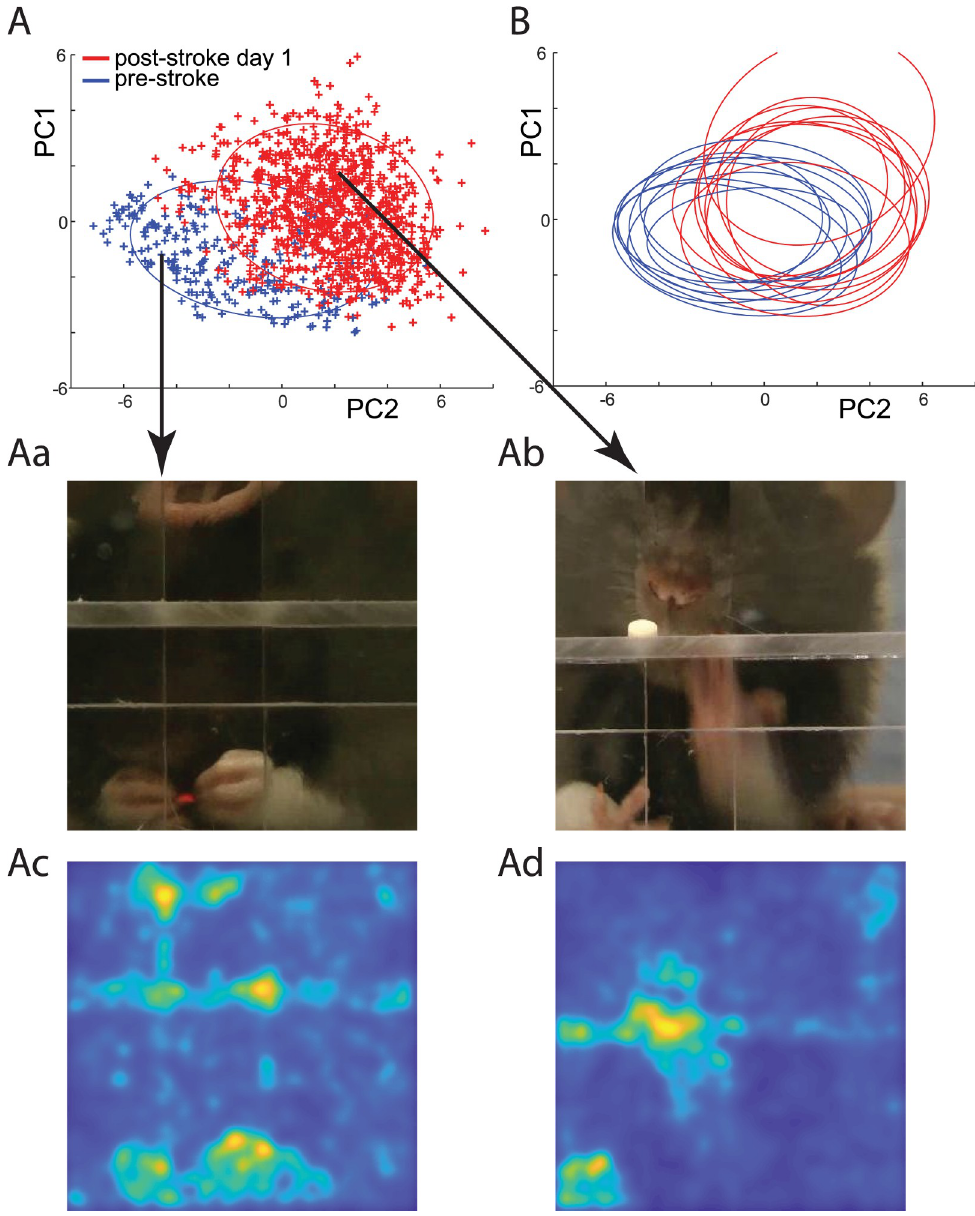
Fig 4. Extracting knowledge from the network to identify the movement elements most predictive of stroke severity. (A) Representation of video frames transformed into the internal feature space of the network (see Methods). Each point represents a single video fame. Blue points represent video frames from a single rat during trials obtained on the day before stroke. Red points represent video frames from trials obtained after stroke for the same rat. Blue and red ellipses outline distributions of points before and after the stroke, respectively. Note the disparity between distributions. For example, eating with both hands (Aa) was only observed before the stroke, whereas reaching for the food pellet with the mouth (Ab) was only observed after the stroke. Panels Ac and Ad illustrate the parts of frames in Aa and Ab that the network evaluated as being most important for its scoring decision. (B) Ellipses outline the distribution of points before the stroke (blue) and on day after the stroke (red) for each rat. Close overlap of the red ellipses indicates that features predictive of stroke found by the network were consistent across rats. The sample network and data on which this figure is based are available at github.com/hardeepsryait/behaviour_net. PC, principal component.